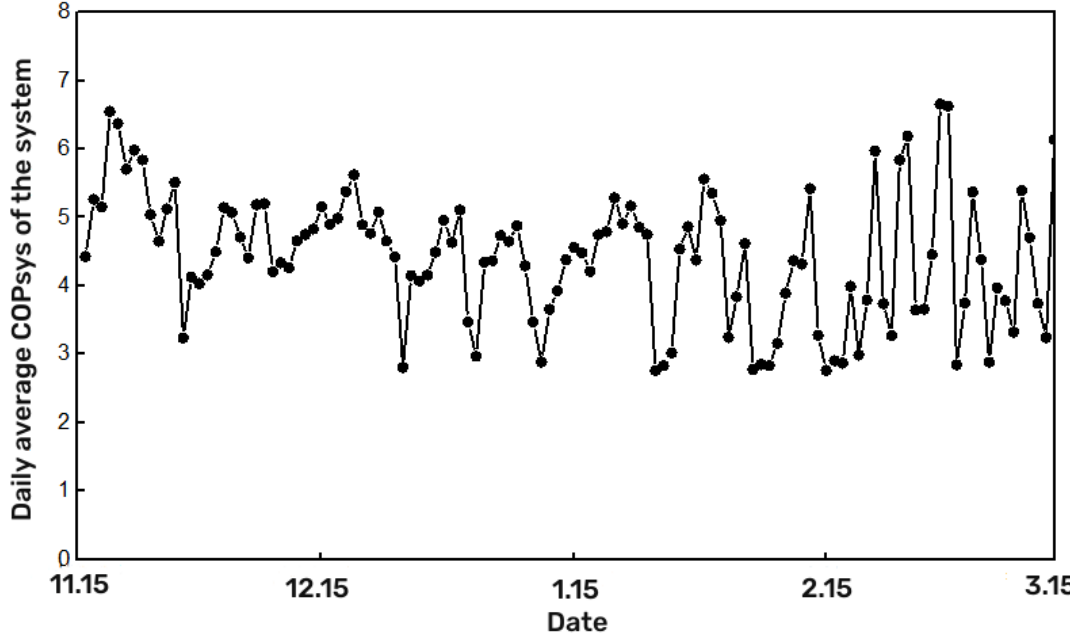
Figure 7. Daily average COP sys of the system. Table 5. Monthly average COP sys of the system.